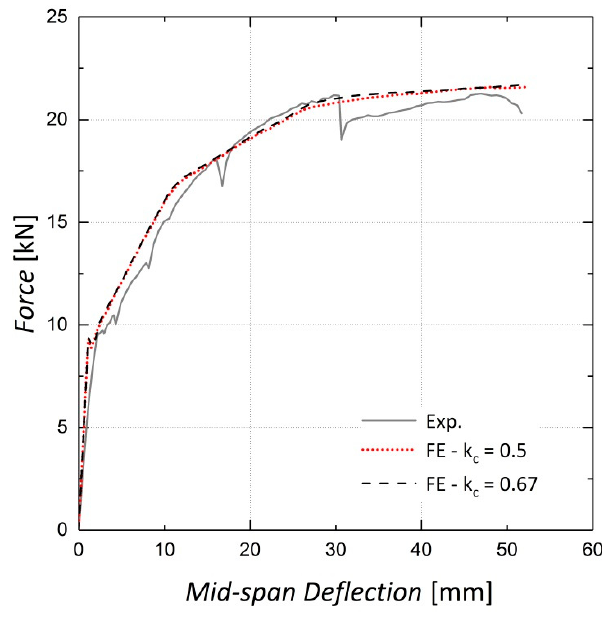
Figure 8. Sensitivity of results to k c —Beam 10.